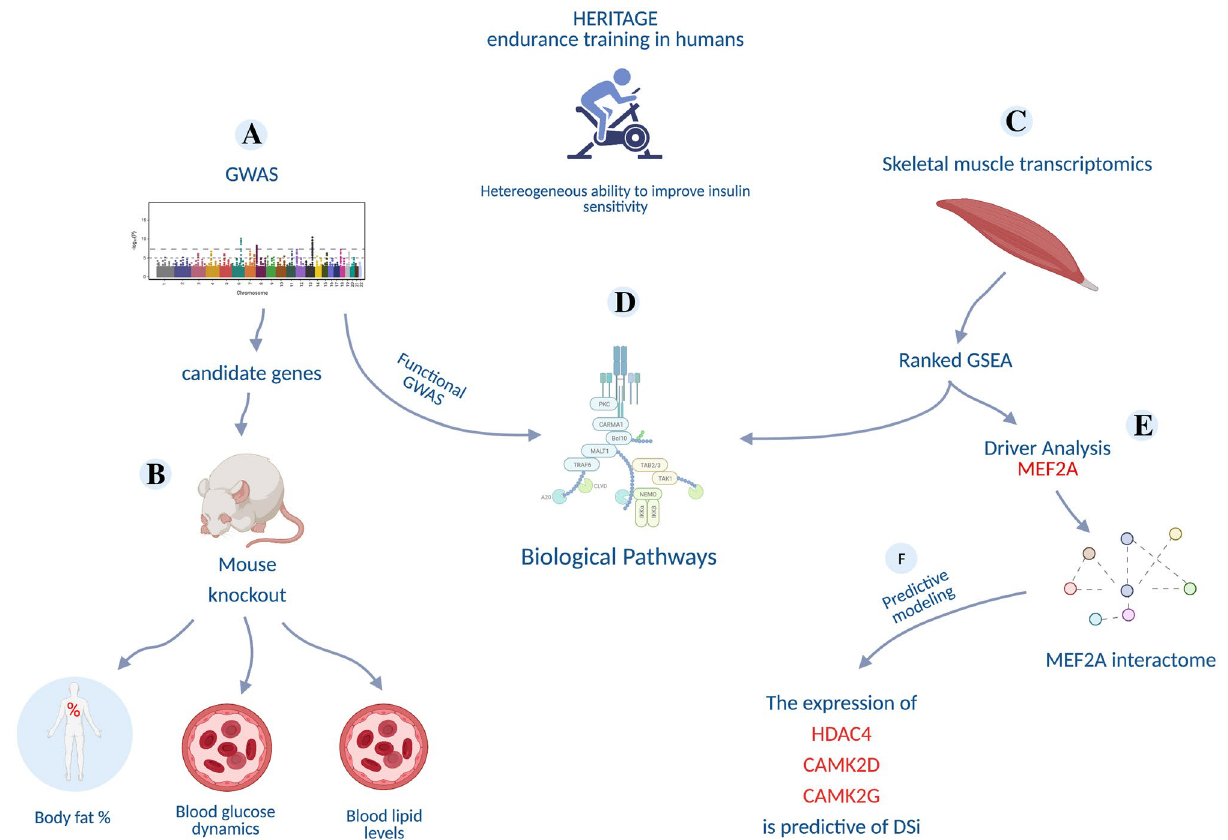
Figure 1. Overview of the study design, consisting of five interconnected steps: ( A ) identification of genetic variants linked to insulin sensitivity index (S i ), ( B ) validation of the corresponding gene candidates in a mouse knock down experiment database, ( C ) identification of transcriptional signatures in skeletal muscles correlating with baseline S i and ∆S i , ( D ) integration of genetics and transcriptomics signatures, ( E ) identification of transcription factors likely to drive the transcriptional signatures linked to ∆S i which led to the identification of MEF2A transcription factor as main driver of the transcriptional profile, and ( F ) development of a statistical model that can predict ∆S i from the transcriptional state of MEF2A interacting